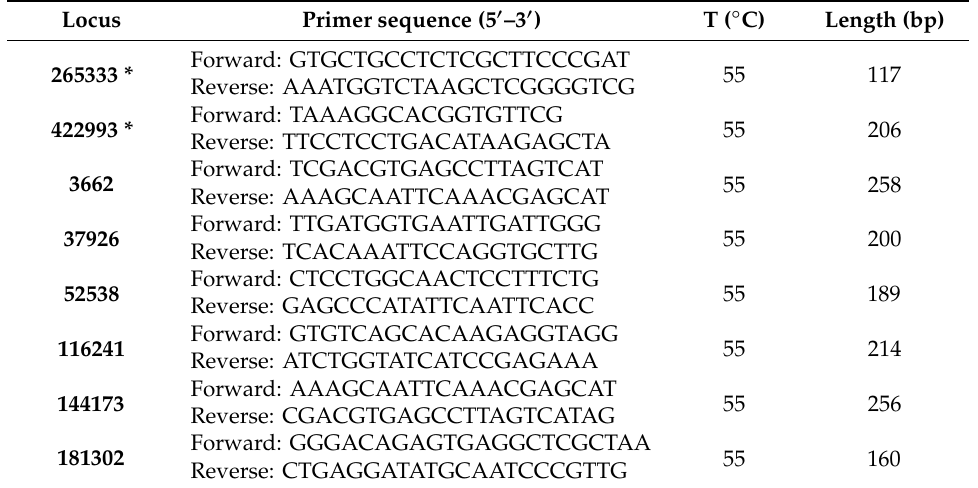
Figure 3. Gel electrophoresis showing the sex-specific PCR amplification of markers 265,333 and 422,993. The locus ID is indicated to the left. Female individuals are represented by the symbol ‘ ♀ ’ and male individuals are represented by the symbol ‘ ♂ ’. ‘M’ indicates a DNA marker. Black arrows indicate the PCR products size.